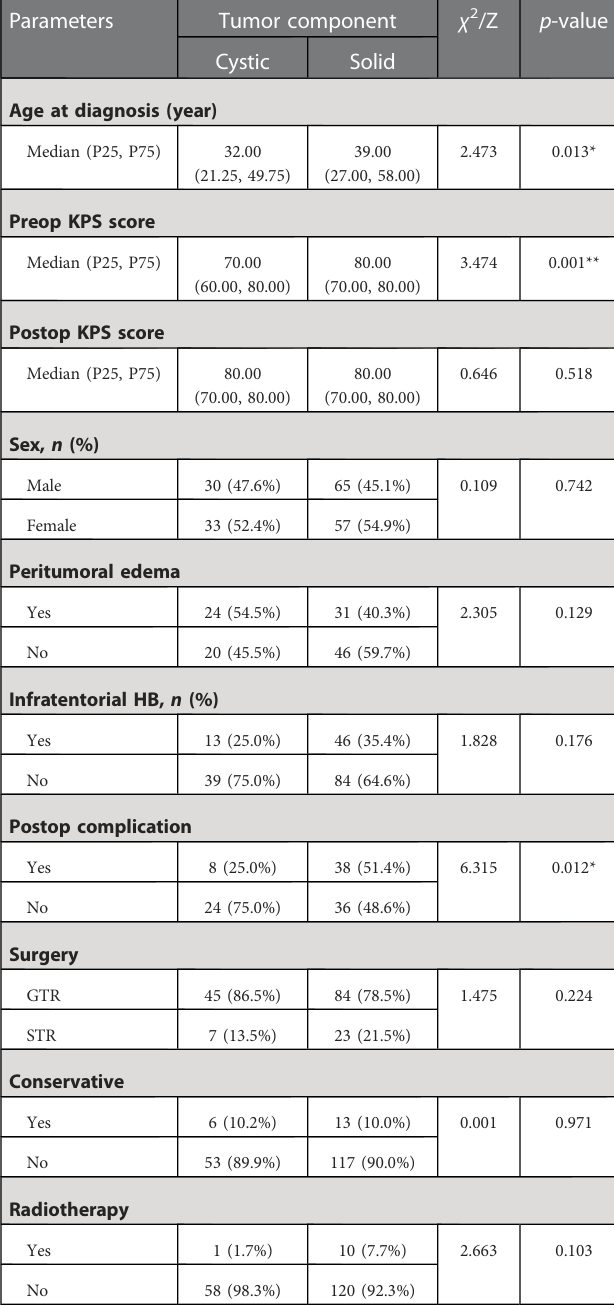
TABLE 2 Comparison of clinical features between cystic and solid cases. Parameters Tumor